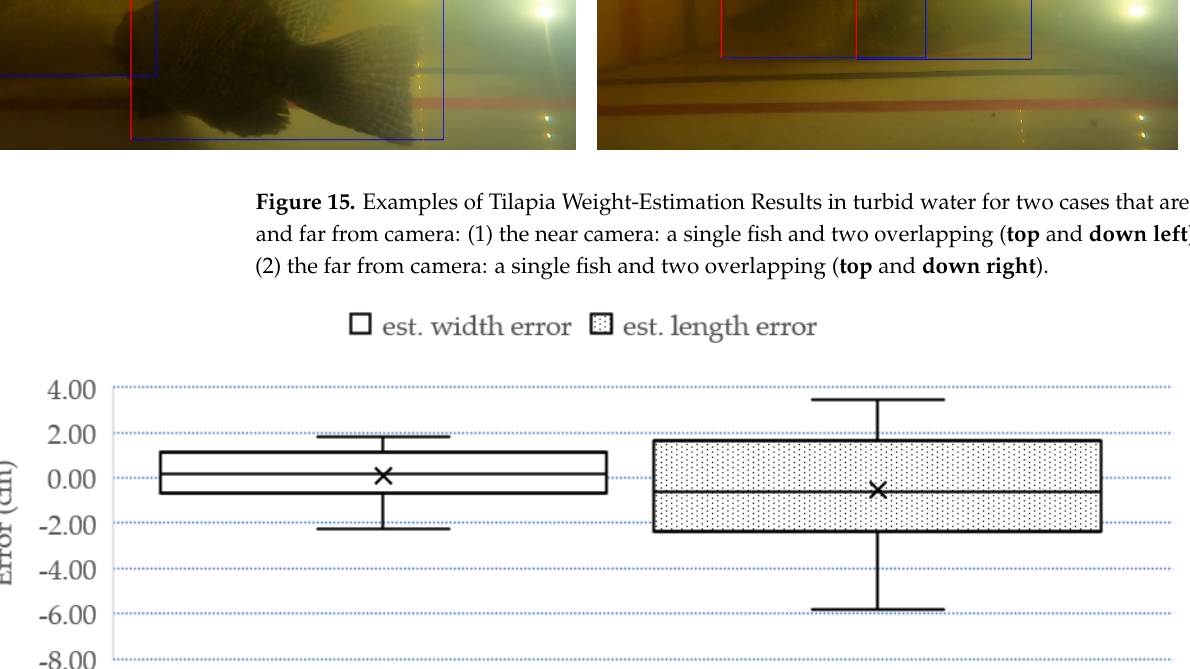
Figure 17. Comparison of the distribution of actual weight and estimated weight by proposed TWE- DRL method. Note that, at 24 weeks of age, the second tank has no data due to all the fish dying and a new set of fish from a reserve tank was supplied instead. The proposed TWE-DRL method has estimated the Tilapia weight given by observed videos where the results show a close resemblance to the actual weight. This is to show the correctness of the proposed method. The next section will demonstrate the performance of the proposed TWE-DRL method, which is given by a dataset of estimates derived from the models. All attributes in the estimated-value dataset were obtained by the models proposed in this paper, i.e., TDepE, TP2CME, and TWE. This dataset was used to train the TDepE, TP2CME, and TWE models by following the same steps in Sections 3.4.1 and 3.4.2. From the experiments, it